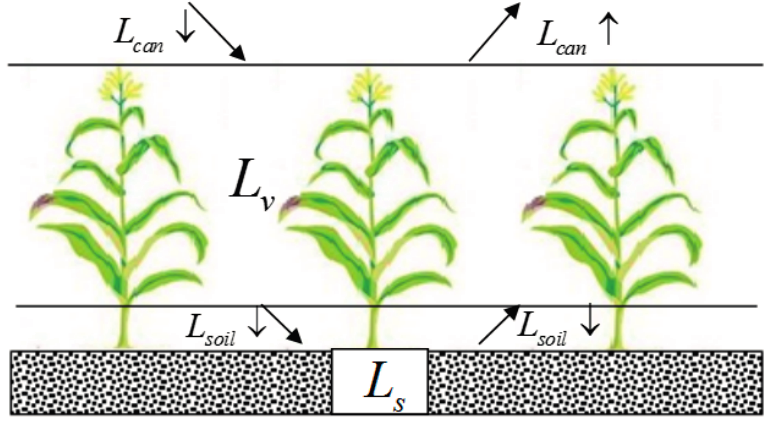
Figure 3. Schematic of the SunScan canopy analysis